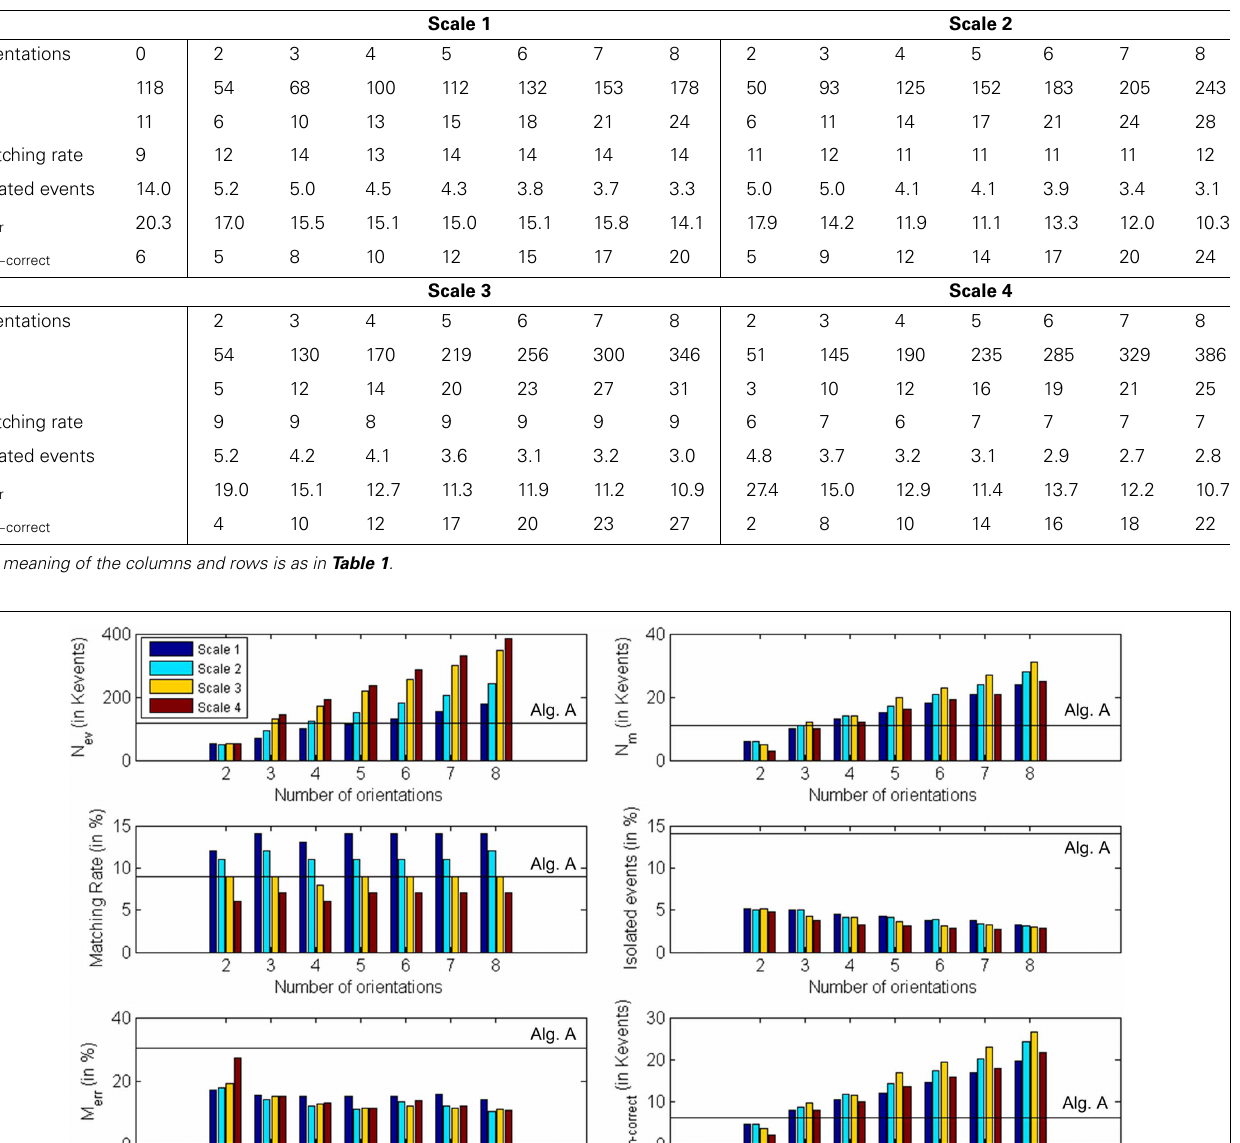
Table 3 | Comparison of the 3D reconstruction results for the cube.